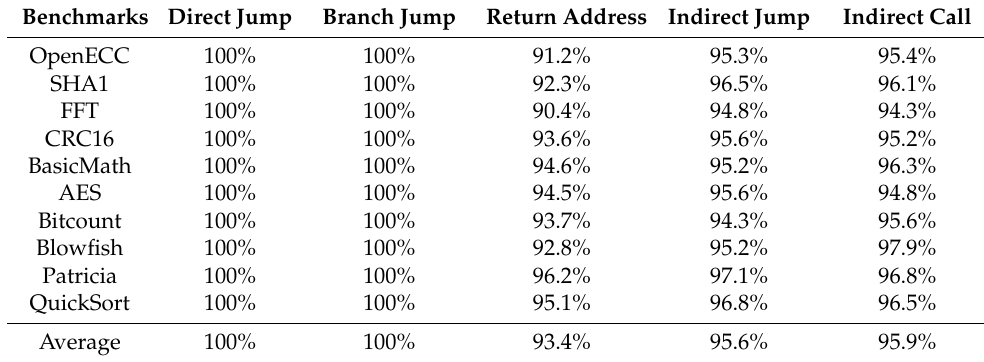
Table 5. Statistics on the detection rate of control flow